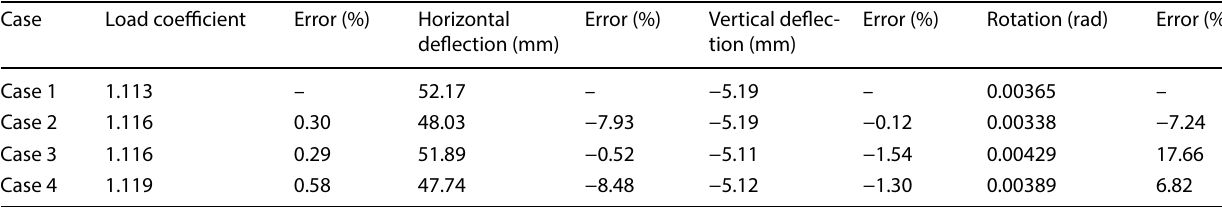
Table 3 Deflection at limit load at point B for six-story frame